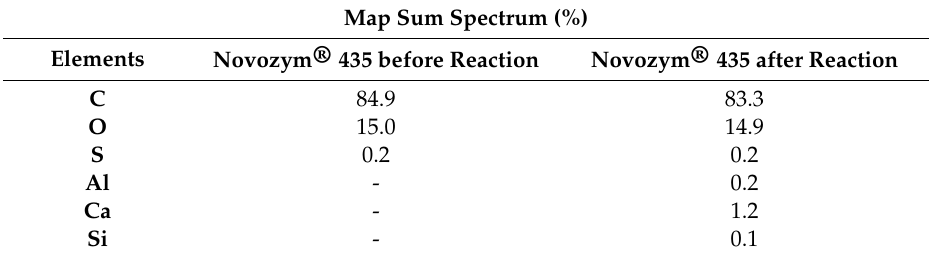
Figure 6. Scanning electron microscopy ( SEM) and mapping obtained of Novozym ® 435 before ( a , b ) and after ( c , d ) the esterification reaction. Table 7. Percentage in weight of the elements on the surface of the Novozym ® 435 before and after the esterification reaction.